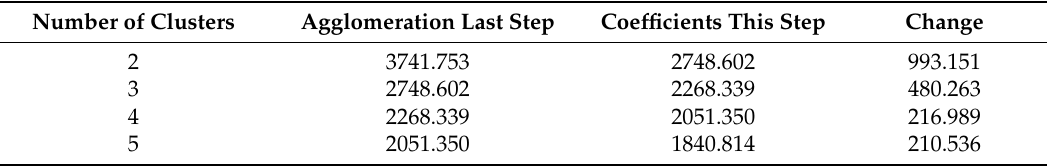
Table 1. Reformed agglomeration